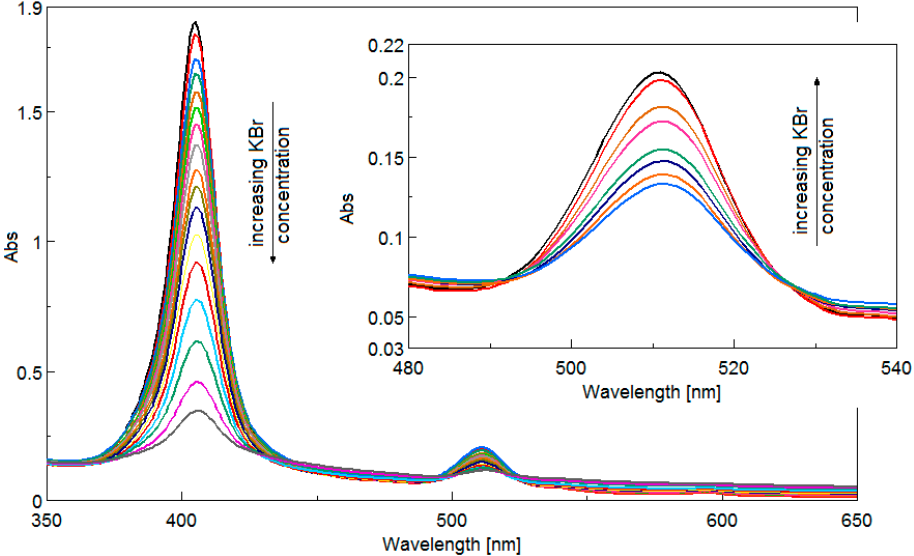
Figure 2. Superposed UV-vis spectra for the spectrometric detection of bromide ions. The inset shows the isosbestic points on the Q band (495 nm; 528 nm).